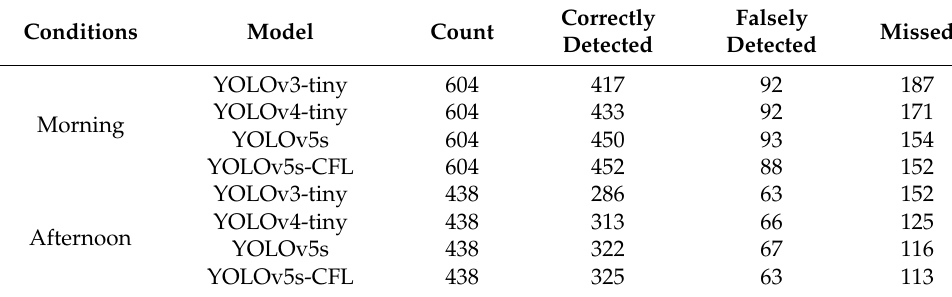
Table 2. The detection results of the four methods with different conditions.